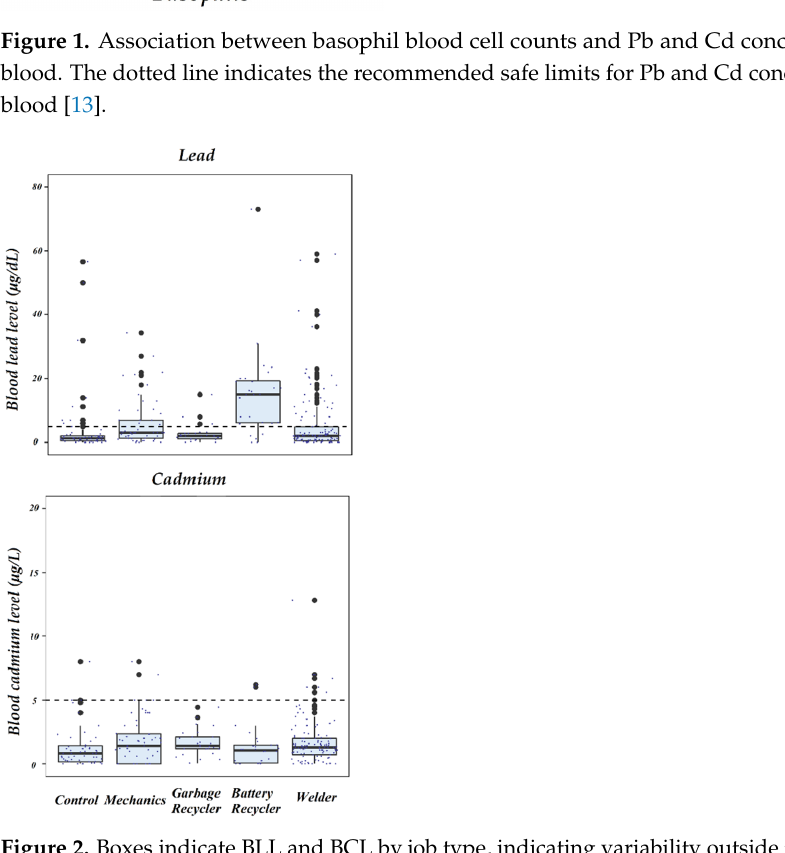
Figure 2. Boxes indicate BLL and BCL by job type, indicating variability outside the upper and lower quartiles. The dotted line refers to the recommended safety limits for Pb and Cd in whole blood [13].